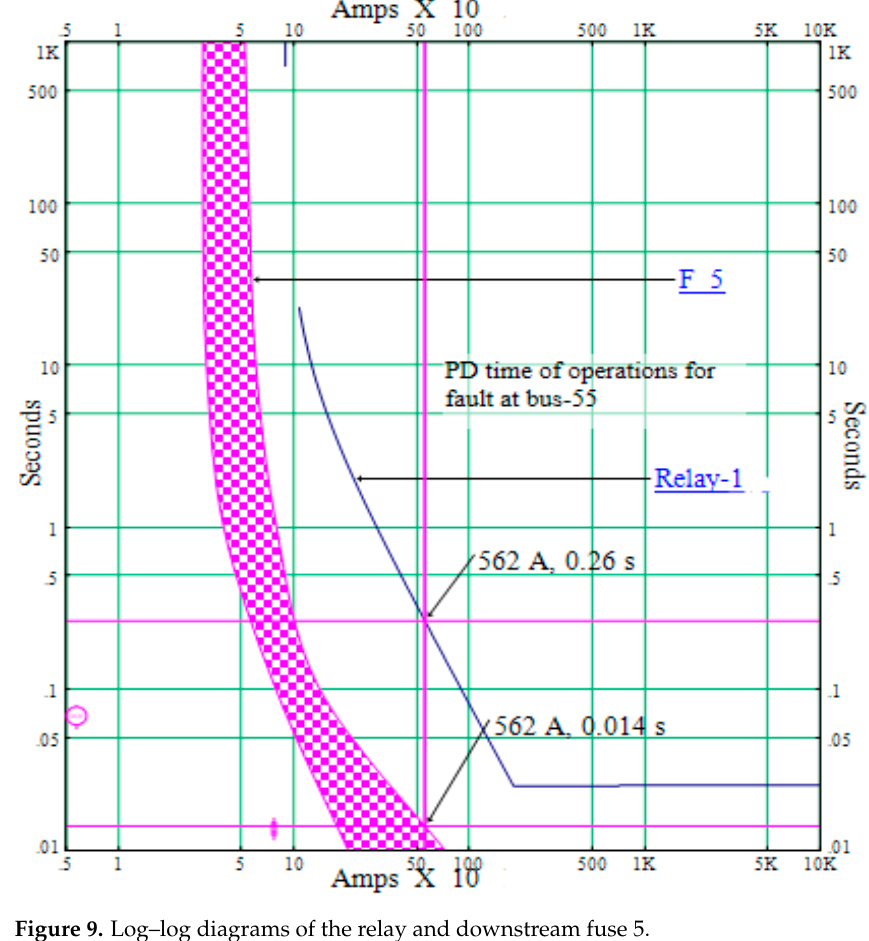
Figure 9. Log–log diagrams of the relay and downstream fuse 5.